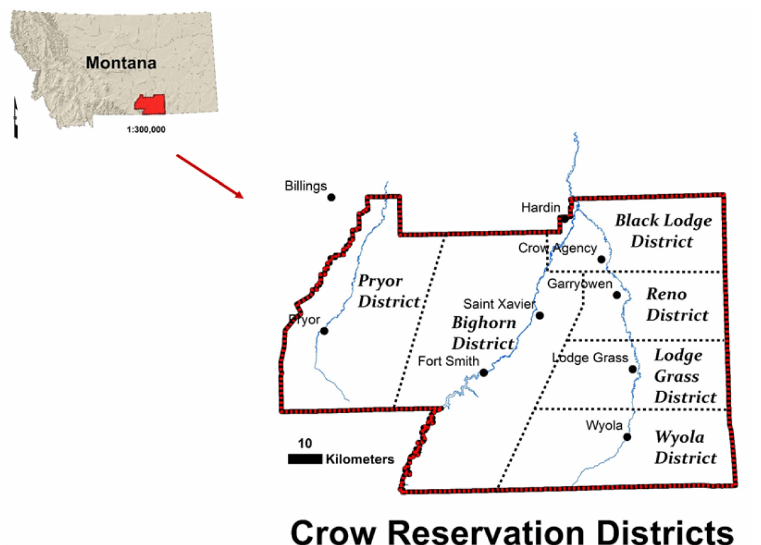
Figure 5. Maps of the Crow Reservation, showing location within Montana and major rivers, towns and traditional districts of the